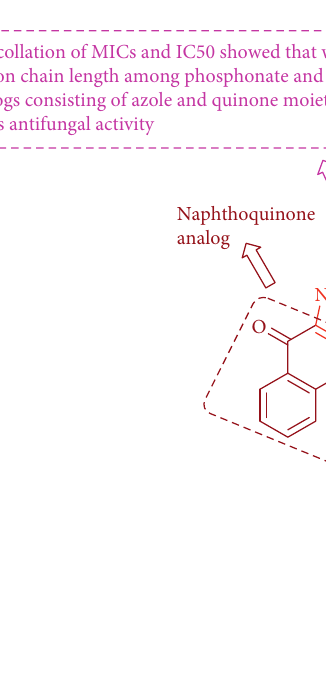
Figure 77: Chemical structure of phosphonates conjugated to azoles and quinones with variable carbon chain